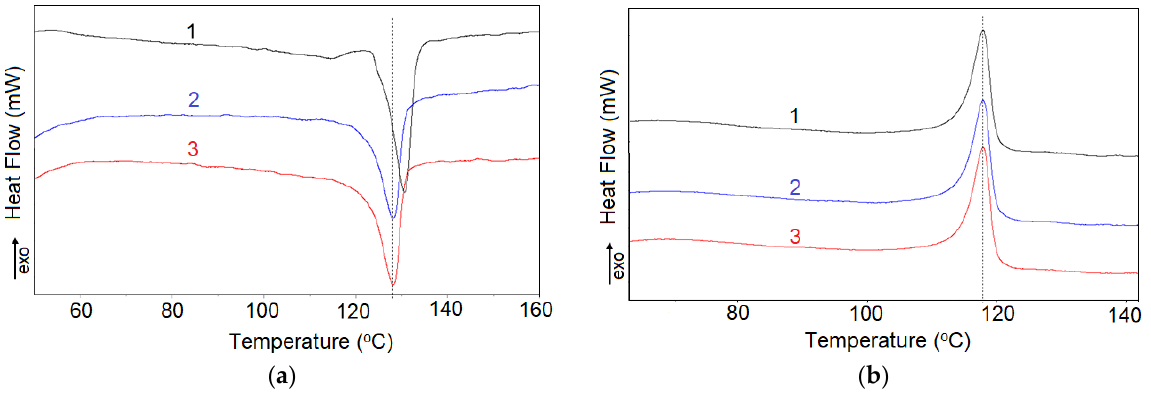
Figure 13. DSC curves from three repeated heating/cooling cycles between r.t. and 170 °C of thermoplastic (CB + HD)/(LLD + HD) composite: ( a ) heating curves (5 °C /min, air); ( b ) cooling curves (5 °C /min, air).